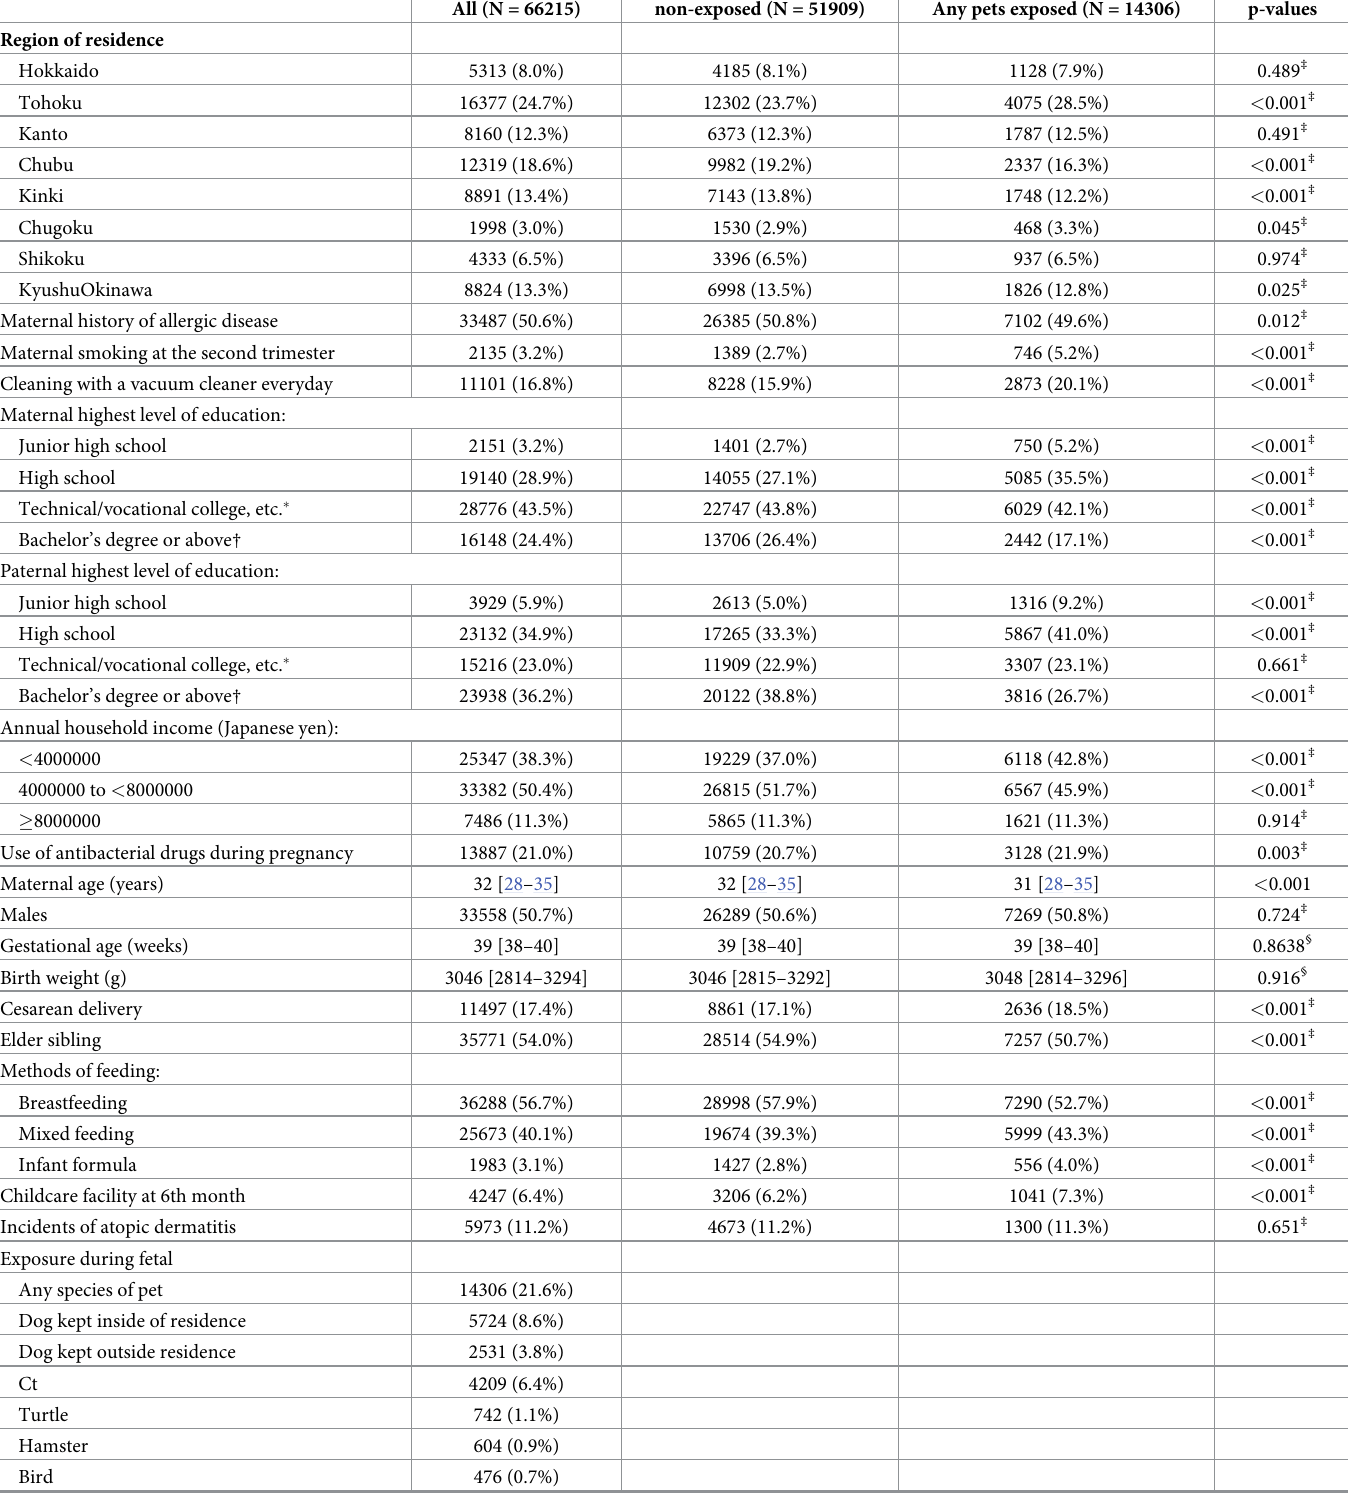
Table 1. Participant